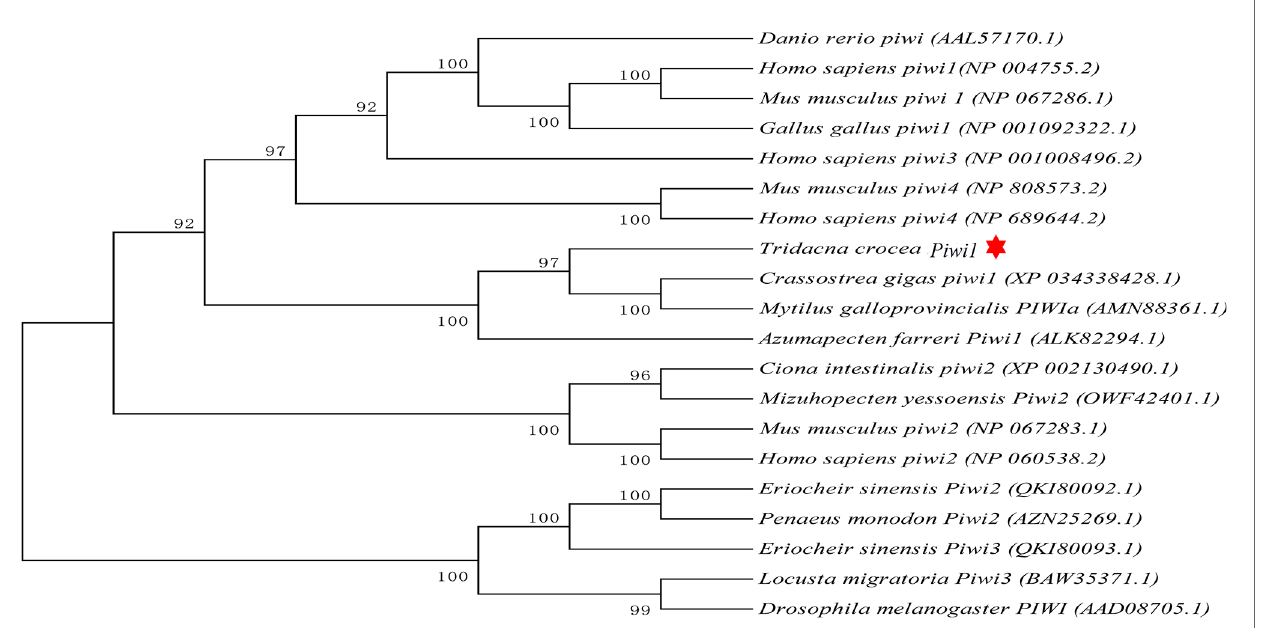
FIGURE 2 | Phylogenetic analysis of Piwi orthologs using the neighbor-joining method with 1,000 bootstrap replications. Tc-Piwi1 protein was marked by a red star.